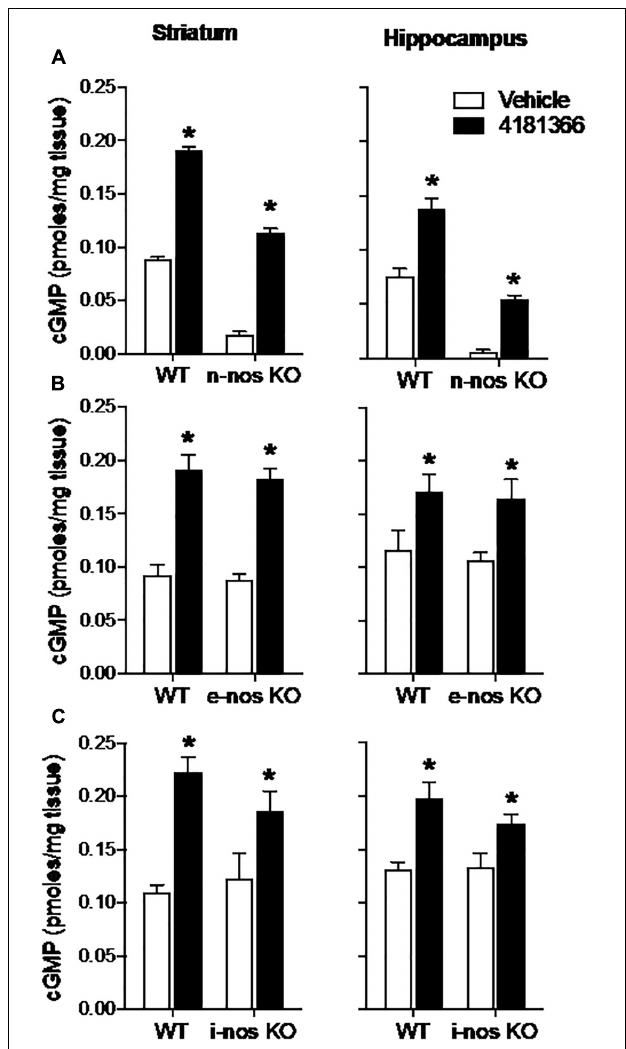
FIGURE 5 | Genetic deletion of nitric oxide synthase (NOS) has no effect on PDE9A inhibitor-induced increase in cGMP. PF-4181366, administered 30 min prior to sacrifice, significantly elevated cGMP content in striatum (Str) and hippocampus (Hip) of nNOS (A) , eNOS (B) , or iNOS (C) knockout mice. Results were analyzed by two-way ANOVA (PDE9A inhibitor X gene status) in each brain region followed by post hoc tests of the effect of the PDE9A inhibitor in each strain, corrected for multiple comparisons. nNOS (A) . In the striatum, there was a significant main effect of PF-4181366 [ F (1, 20) = 1297, P < 0.0001], and a main effect of nNOS knock out [ F (1, 20) = 718.3, P < 0.0001] but not an interaction [ F (1, 20) = 1.471, P = 0.2394]. Similarly, in the hippocampus, there was a significant main effect of PF-509783 [ F (1, 19) = 82.01, P < 0.0001], and a main effect of strain [ F (1, 19) = 155.7, P < 0.0001] but not an interaction [ F (1, 19) = 1.437, P = 0.2453]. Subsequent post hoc tests indicated that the cGMP increase observed